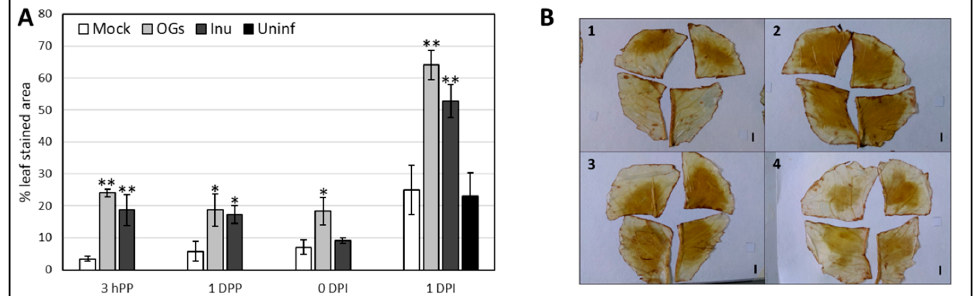
Figure 4. Induction of H 2 O 2 accumulation by OGs and inulin priming. Mock = water-primed leaves; OGs = OGs-primed leaves; Inu = chicory inulin-primed leaves; Uninf = water-primed leaves inoculated with a mock solution (1/2 strength Potato dextrose broth). ( A ) The bar charts illustrate the percentage of DAB (3,3 ′ -diaminobenzidine) stained leaf area in mock-treated and primed leaves at different time-points. 3 hPP= 3 h post priming; 1 DPP = 1 day post priming; 0 DPI = 0 days post inoculation; 1 DPI = 1 day post inoculation. Asterisks indicate statistically significant differences between treatments and mock for each time-point (* p < 0.05, ** p < 0.01) according to Students t -test. The experiment